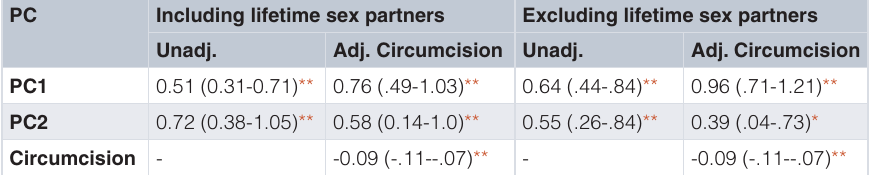
Table 3. Mixed effects multiple regression with HIV-prevalence by region as outcome variable [Coefficient (95% CI)]. PC Including lifetime sex partners Excluding lifetime sex partners Unadj. Adj. Circumcision